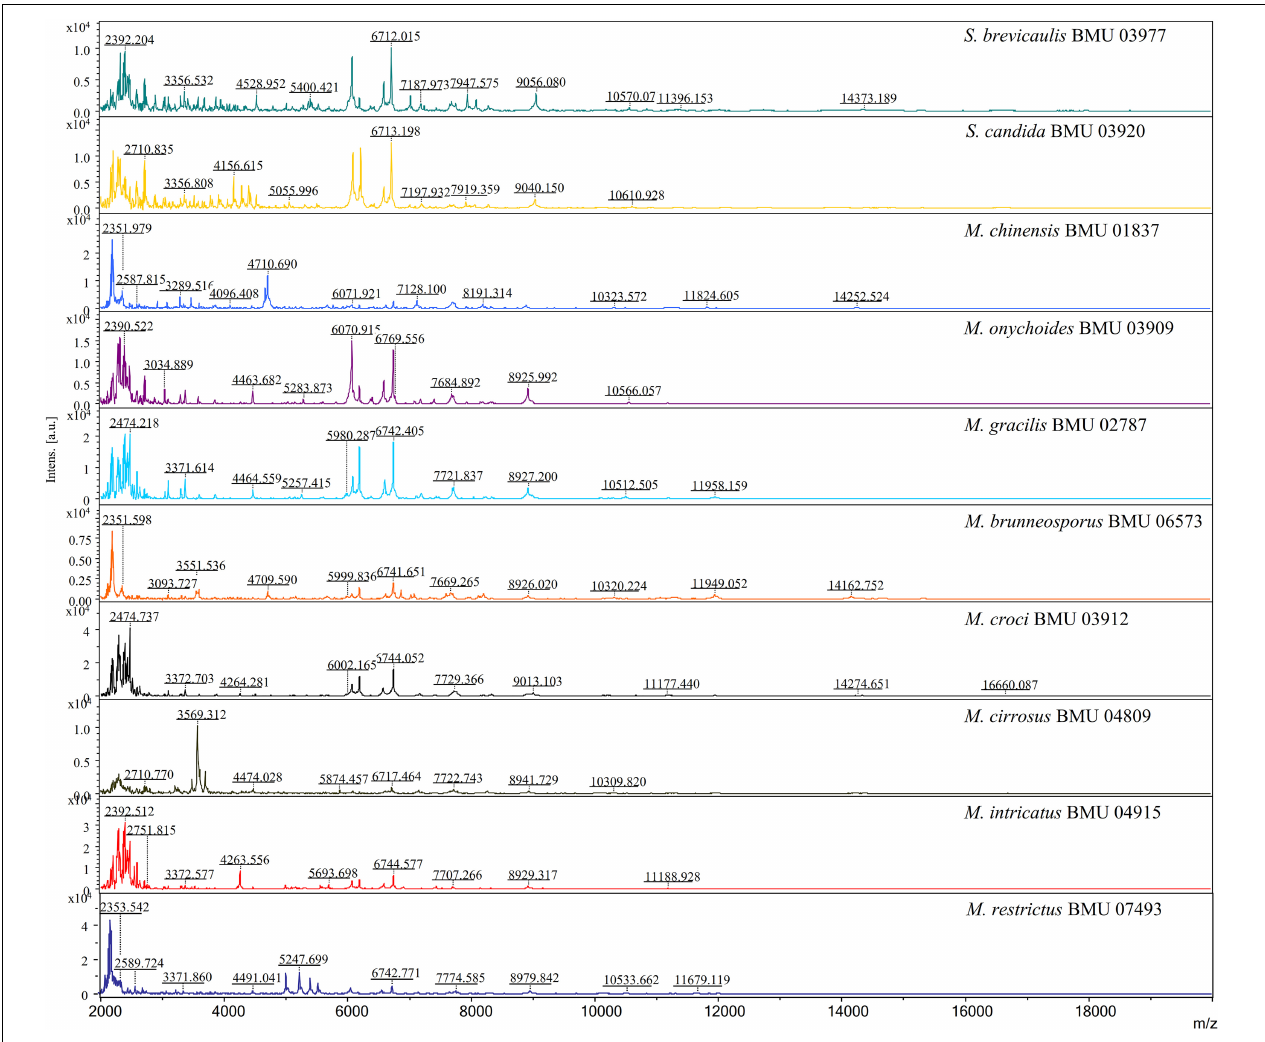
FIGURE 3 | Matrix-assisted laser desorption ionization-time-of-flight mass spectra (m/z 2,000 to 20,000) of Scopulariopsis and Microascus